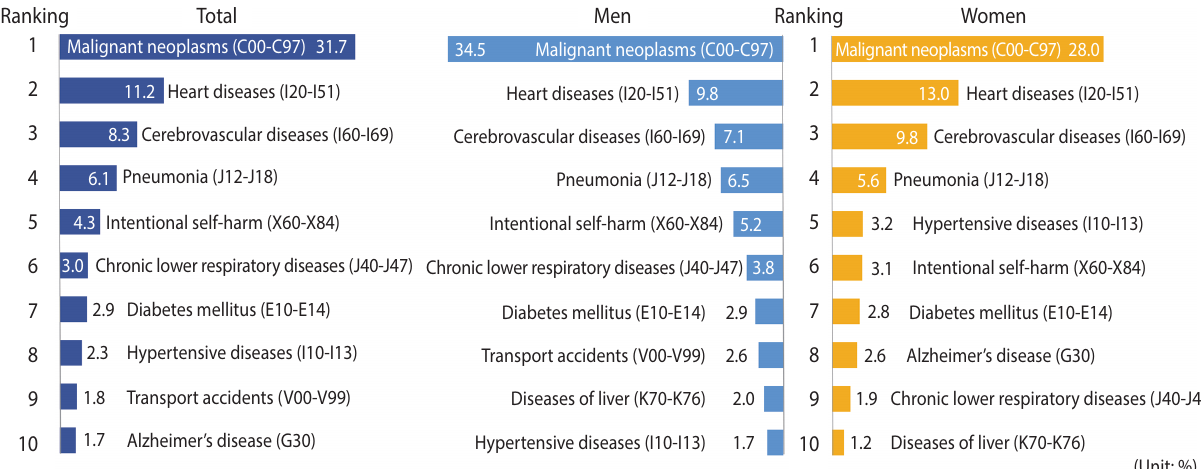
Figure 1. The 10 leading causes from 56 selected cause [12] of death among adults aged 19 years and over in the Korea National Health and Nutrition Examination Survey linked Cause of Death data (dataset